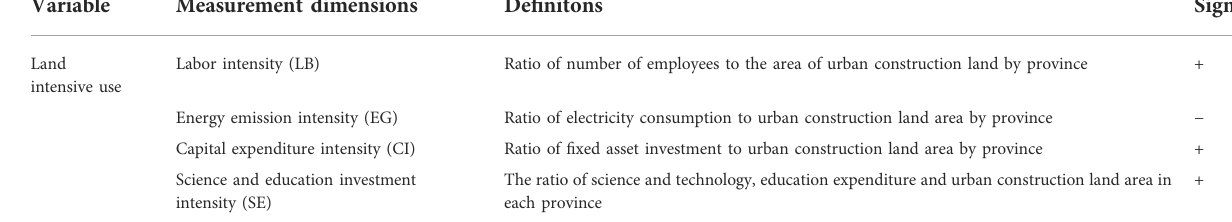
TABLE 2 Comprehensive indicator system of land intensive use.